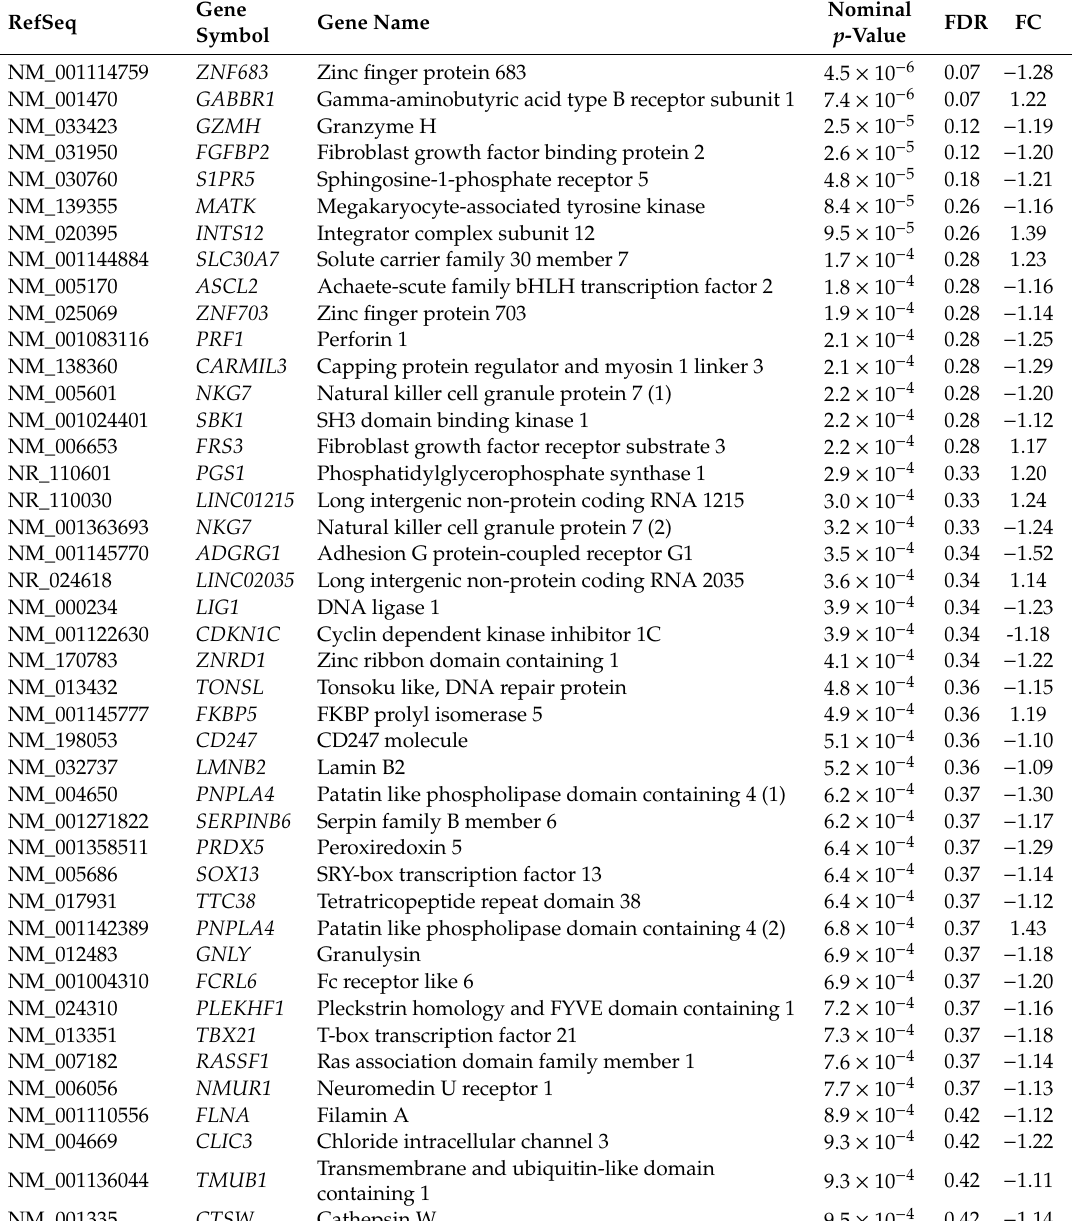
Table 5. List of the most significant di ff erentially expressed genes in Rb group after 8 weeks of Rb